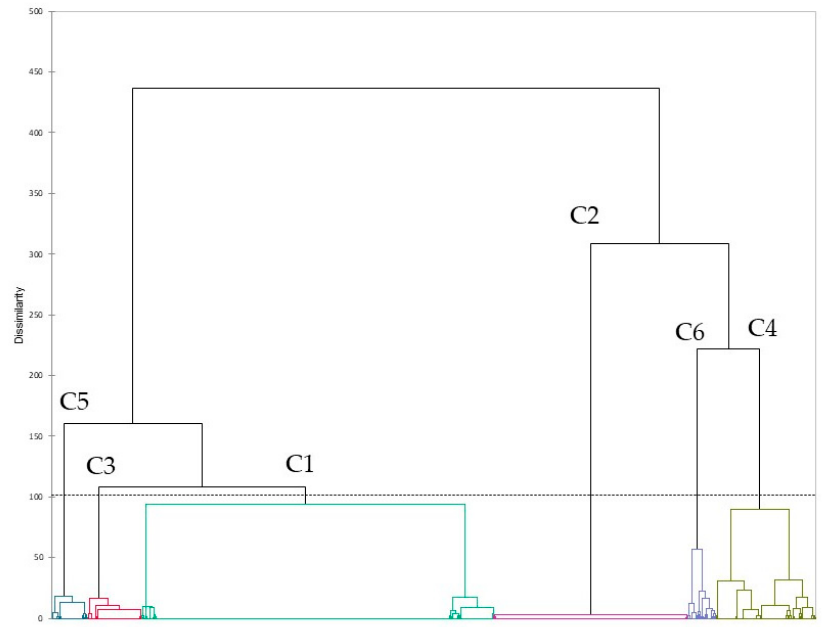
Figure 1. Dendrogram obtained from cluster analysis of the 1824 sequences based on antimicrobial genes frequency.